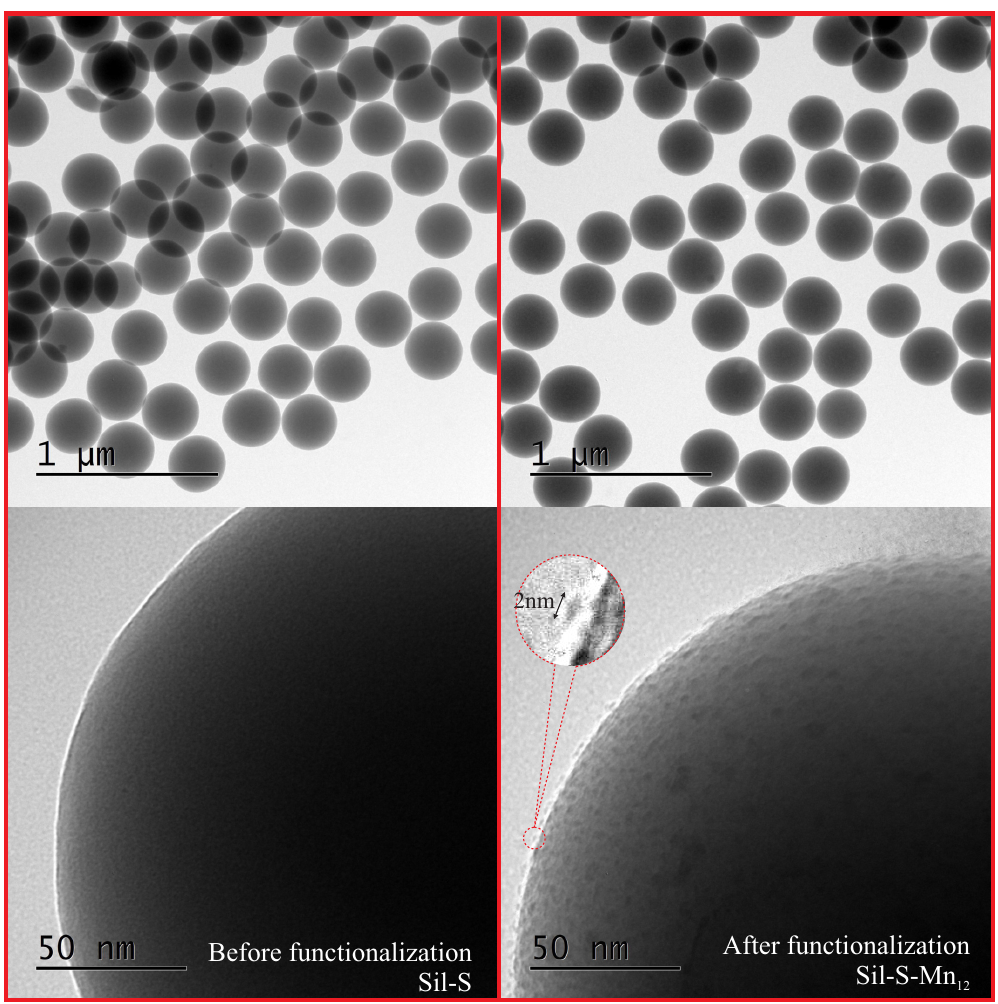
Figure 3. The transmission electron microscopy images of the composite material: individual Mn 12 -stearate molecules attached to the spherical silica surface (Sil-S-Mn 12 —right side) in comparison with the pure spherical silica nanoparticles